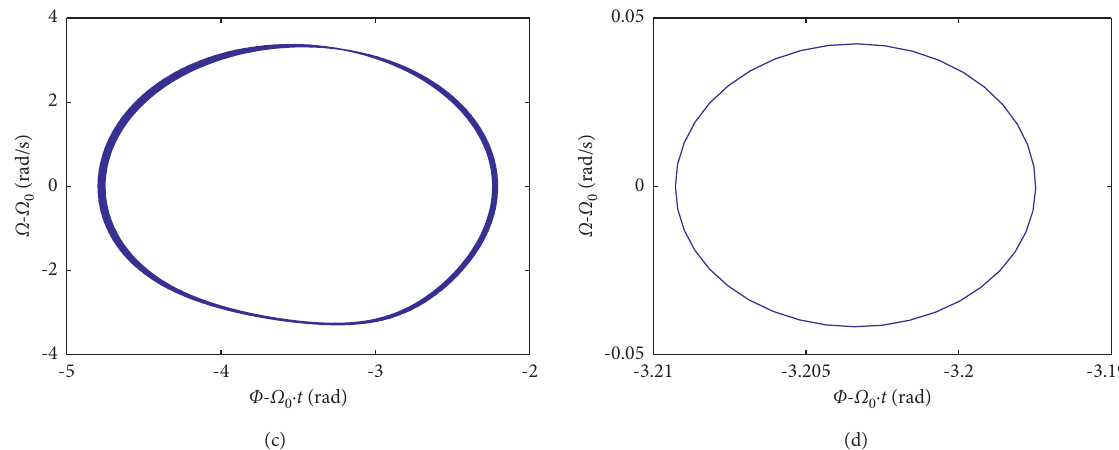
Figure 10: Phase diagram of the axial direction and torsional direction, k � 38rpm, and (d) Ω (c) Ω 0